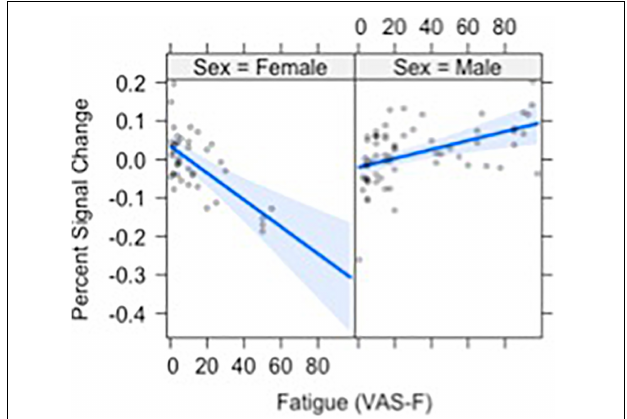
FIGURE 4 | The relationship between visual analog scale of fatigue (VAS-F) and Gender in the orbito-frontal gyrus is shown. For women (left) the relationship between VAS-F and activation was negative; for men (right) it was positive. The blue line represents the best fitting linear relationship between VAS-F and age. The 95% confidence interval around this line is plotted in lighter